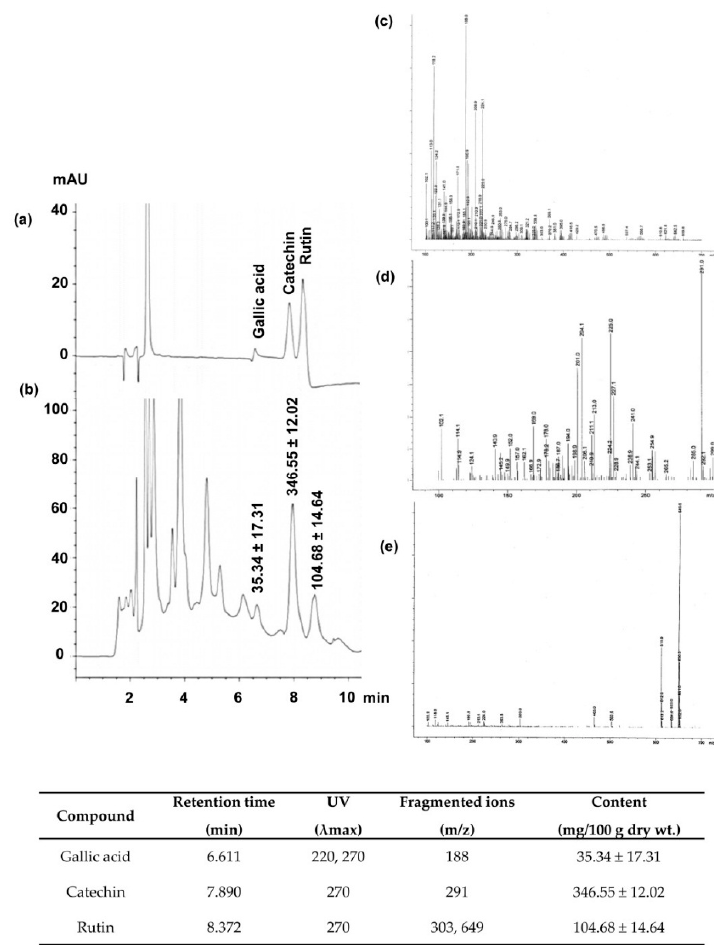
Figure 1. HPLC/DAD/MS analysis of C. nervosum fruit extract (CNFE). ( a ) Chromatogram at 270 nm of reference standards and ( b ) chromatographic peaks of the extract, ( c – e ) electron ionization mass spectra of gallic acid, catechin, and rutin, respectively. Numerical values in ( b ) denote the amount of individual compound detected. Data (mean ± SEM, n = 3) are expressed in mg/100 g dry weight of the extract. The identity, retention time, maximum UV absorption wavelength ( λ max ), and fragment ions for each identity are compiled and presented at the bottom end of the image.